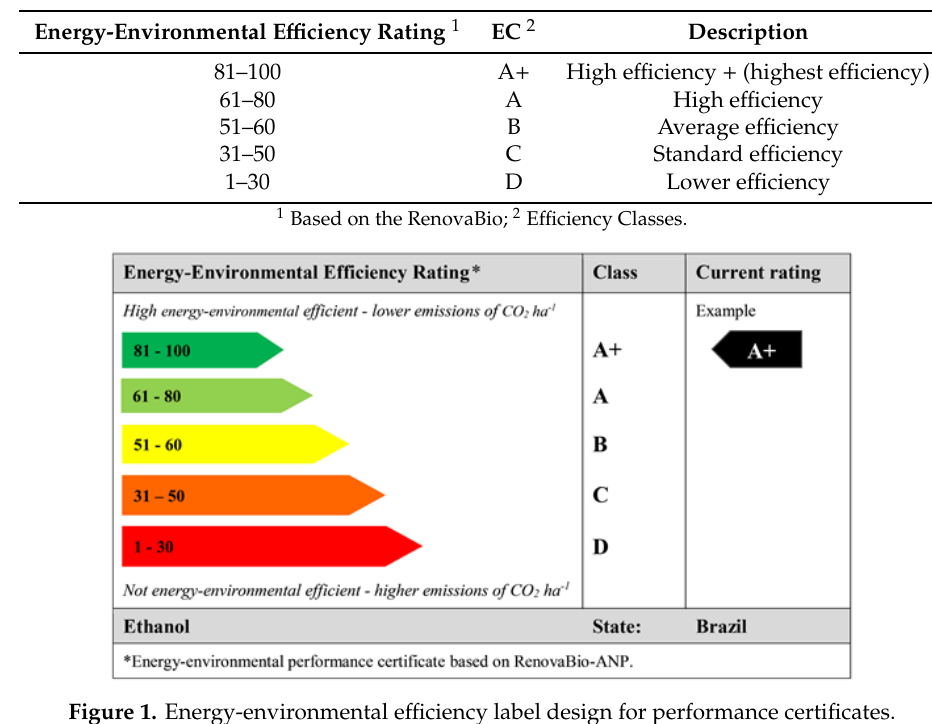
Figure 1. Energy-environmental e ffi ciency label design for performance